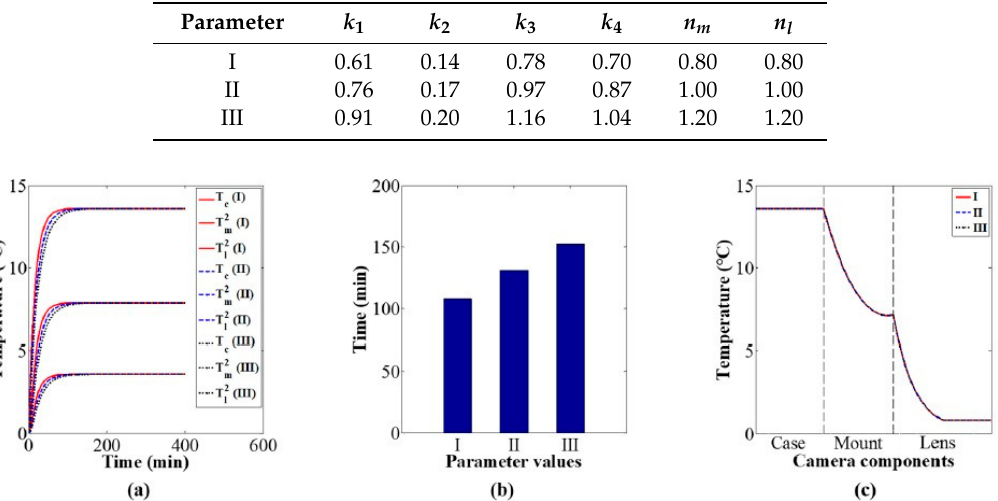
Figure 10. Effect of specific heat parameters on camera component temperature variation and distribution: ( a ) components temperature variation, ( b ) thermal equilibrium time, and ( c ) distribution of equilibrium temperature.